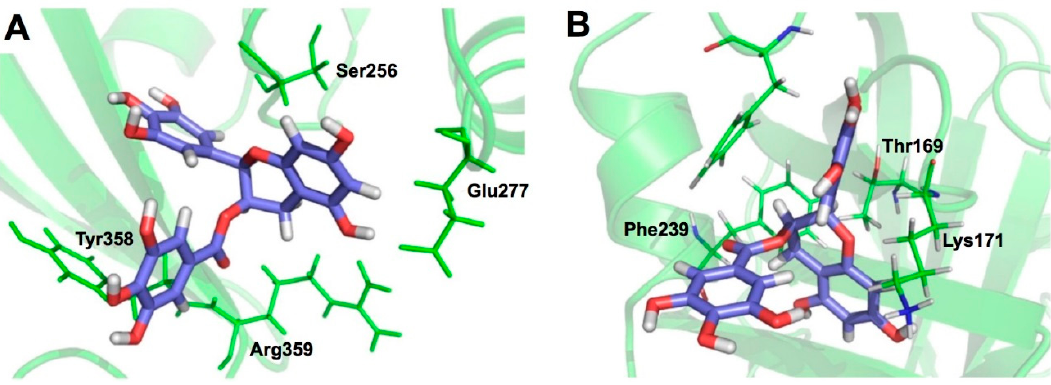
involvement of Ser256, Glu277, Tyr358, and Arg359 in PLY and Thr167, Lys169, and Phe237 in